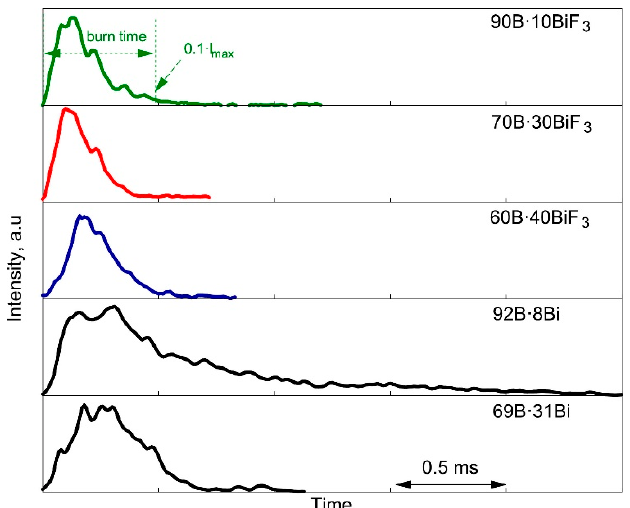
Figure 17. Characteristic emission records of the burning in air particles of B·BiF 3 and B·Bi composites. Reproduced from [56], with permission from Elsevier, 2020.